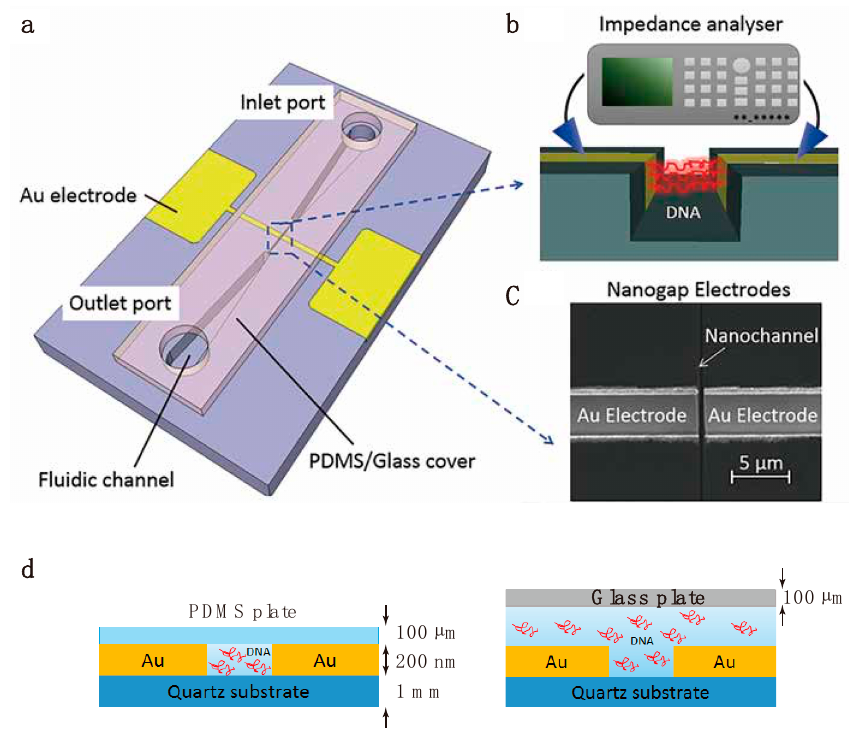
Figure 1. Measurement device and setup. ( a ) Schematic of the nanofluidic measurement device having a nanochannel located between two nanogap measurement electrodes. The electrodes are fully embedded in the quartz substrate to create a uniform electric field in the measurement area and to better seal the cover plate. Two types of cover plates, glass or polydimethylsiloxane (PDMS) (both 100 µm thick), were used to seal the nanochannel. ( b ) Schematic of the fluidic operation and electrical configuration of the measurement device. ( c ) Magnified scanning ion microscopy image of the measurement area. ( d ) The two cover plates used to assemble the device. The PDMS cover confined the DNA within the nanochannel to allow for quantitative electrical impedance measurements, whereas the glass cover was used to observe the dynamic behavior of DNA in the nanochannel.